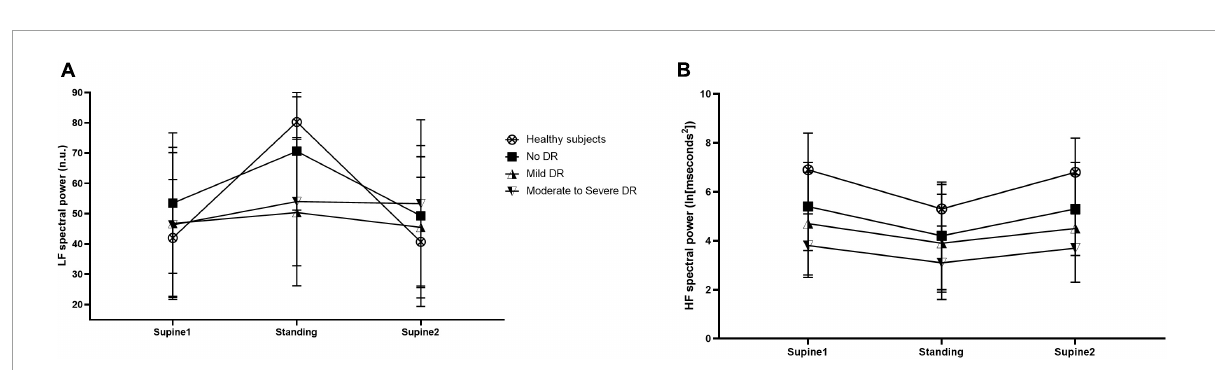
FIGURE3 Normalized low-frequency (LF) spectral power of heart rate variability (HRV) in normalized units (nu) (A) and high-frequency (HF) spectral power (B) in healthy controls (open circles), patients with no diabetic retinopathy (no DR) (black squares), patients with mild diabetic retinopathy (mild DR) (upward triangles), and patients with moderate to severe diabetic retinopathy (moderate to severe DR) (downward triangles) before, during and after the orthostatic challenge. Data are presented as mean ±